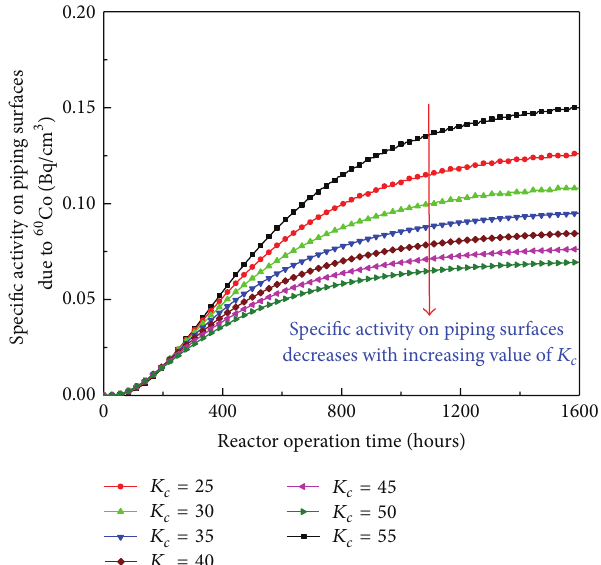
Figure 11: Specific activity of 60 Co in primary coolant of PWR with different values of 𝐾 𝑝 . Table 5: Specific activity of 58 C0 and 60 Co with various 𝐾 𝑝